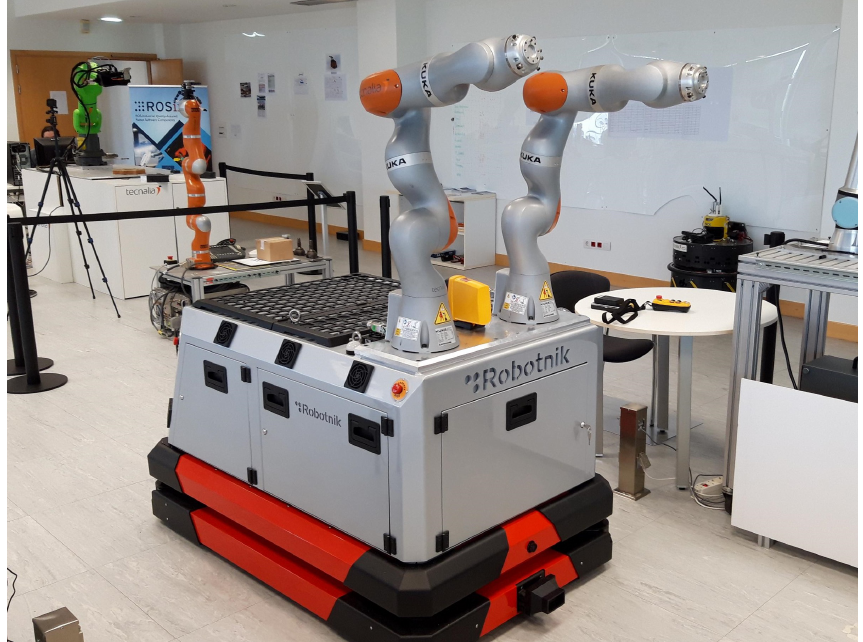
Figure 12. New AIMM of the European Sherlock project that was designed and manufactured during the testing and writing of this